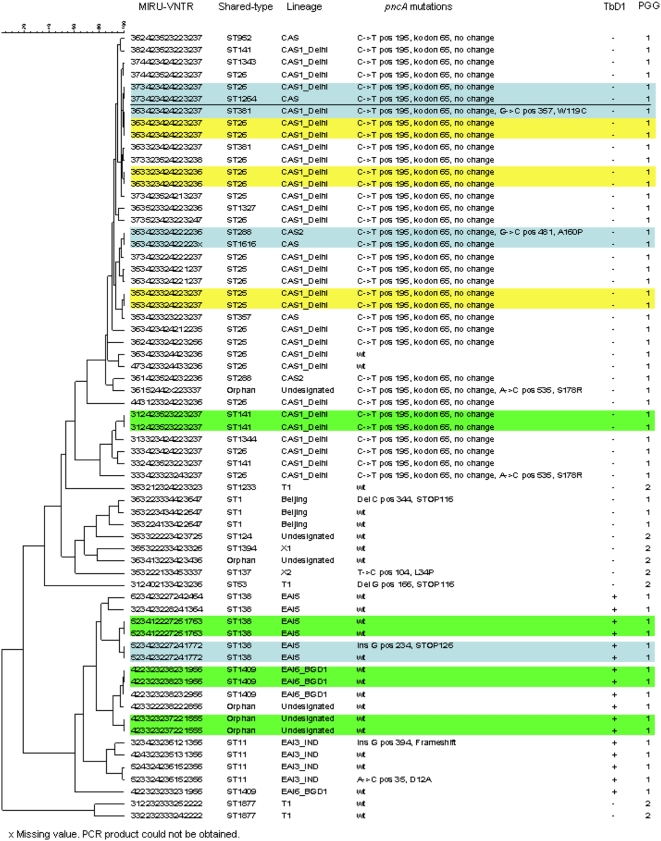
Diversity of 65 M. tuberculosis isolates from New Delhi, India deduced from MIRU-VNTR, spoligotyping and single nucleotide polymorphism analyses.MIRU-VNTR clusters that could be discriminated by spoligotyping are highlighted in blue and clusters that could be discriminated based on mutations in the katG, rpoB and/or embB genes are highlighted in yellow. Clusters that could not be discriminated using a combination of all markers are highlighted in green. The dendrogram was produced following Pearson correlation and unweighted pair group method with arithmetic average analysis.